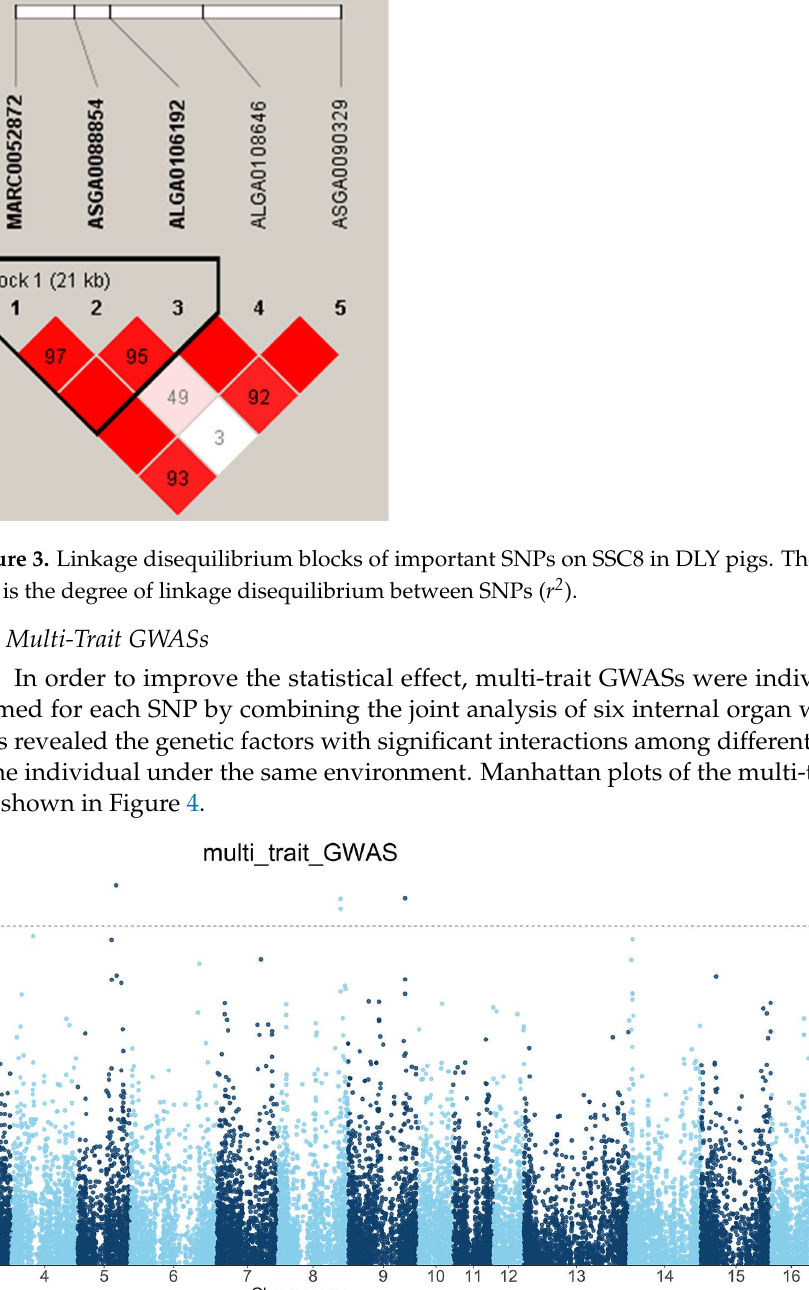
Figure 5. Venn diagram showing the distribution of SNPs in the single-trait GWASs and multi-trait GWASs, highlighting the role of pleiotropic SNPs in multiple traits.